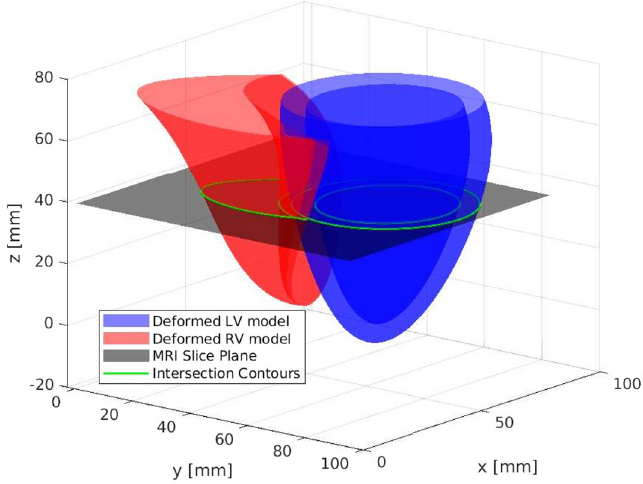
Figure 6. Shows the intersection of the biventricular deformable model and MRI slice plane.